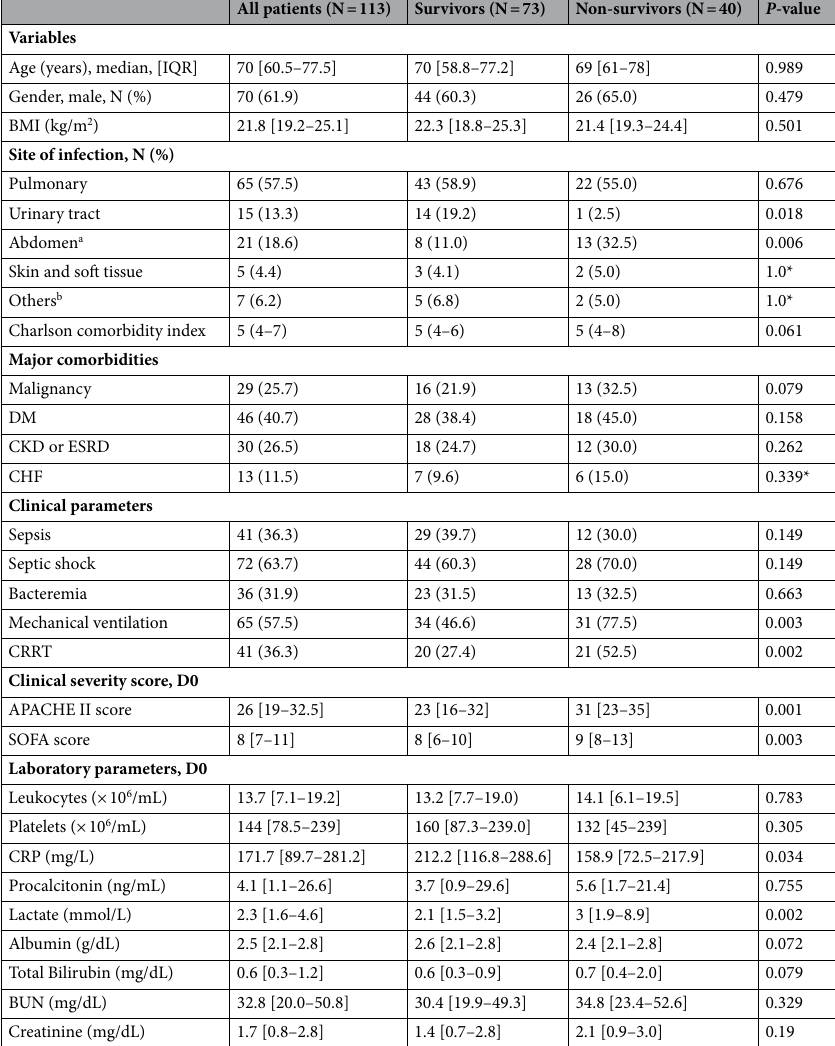
Table 1. Comparison of characteristics of sepsis and septic shock patients according to 28-day mortality. BMI body mass index, DM diabetes mellitus, CKD chronic kidney disease, ESRD end stage renal disease, CHF congestive heart failure, CRRT continuous renal replacement therapy, APACHE Acute Physiology and Chronic Health Evaluation, SOFA Sequential Organ Failure Assessment, CRP C-reactive protein, BUN Blood urea nitrogen, ABGA arterial blood gas analysis. Values are expressed as n (%) or median [interquartile range] unless otherwise indicated. *Fisher exact test. a Abdomen: gastrointestinal and hepatobiliary infection, peritonitis. b Others: meningitis, spinal abscess, septic arthritis, primary unknown